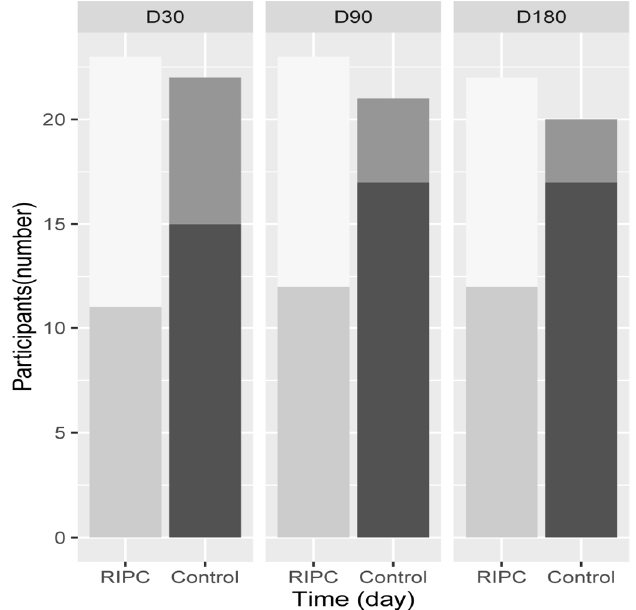
Figure 3. Barplot of postoperative complications (American College of Surgeons) at day 30 (11/23 (47.82%) vs. 15/22 (68.18%)), day 90 (12/23 (52.17%) vs. 17/21 (80.95%)) and day 180 (12/22 (54.55% vs. 17/20 (85%)), p = 0.003 in the intervention (RIPC) and control groups, respectively. RIPC group without morbidity, RIPC group with morbidity, Control group without morbidity,